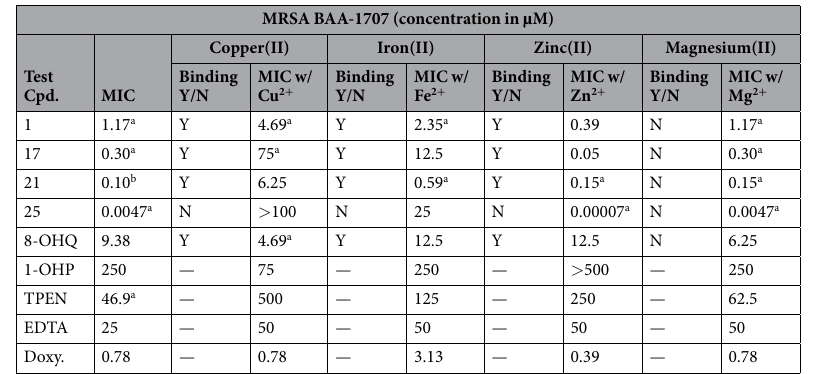
Table 2. UV-Vis and metal(II)-cation co-treatment MIC assays summary for HPs against MRSA BAA-1707. Note: a Midpoint for a 2-fold range in observed values. b MIC for 21 in these experiments was 0.1 µ M. UV-Vis results are reported as “Binding Y/N” for HPs. Each metal(II) cation was tested at 200 µ M in co-treatment MIC assays. 8-OHQ (8-hydroxyquinoline) and 1-OHP (1-hydroxyphenazine) were used as positive controls and have metal-binding moieties related to